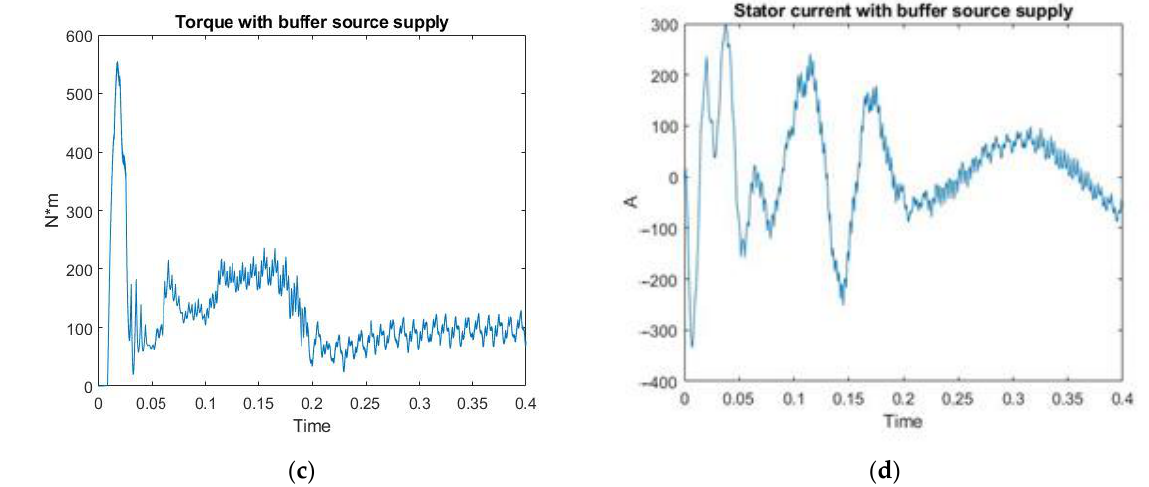
Figure 12. Output characteristics when using a supercapacitor as a buffer source of electricity: ( a ) speed; ( b ) flux; ( c ) torque and ( d ) current.